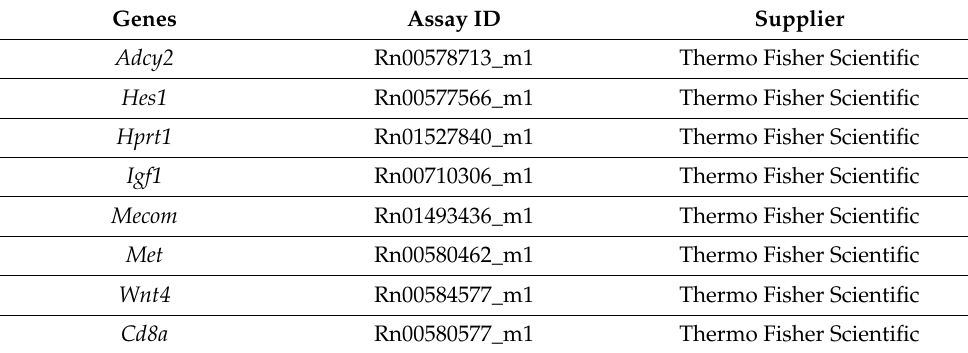
Table 3. Probes used for